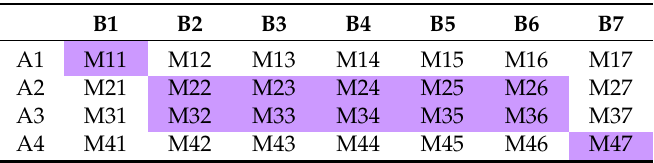
Table 4. Feasible set of river operation management